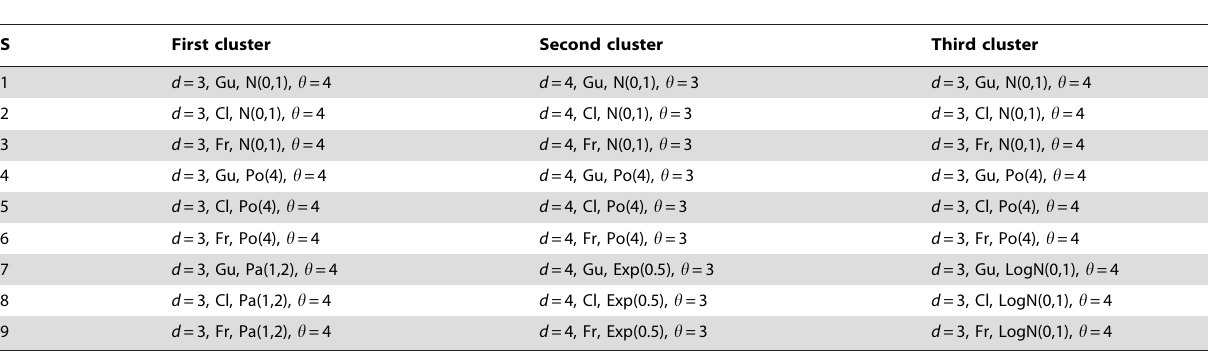
Table 1. Description of the scenarios used in the simulation